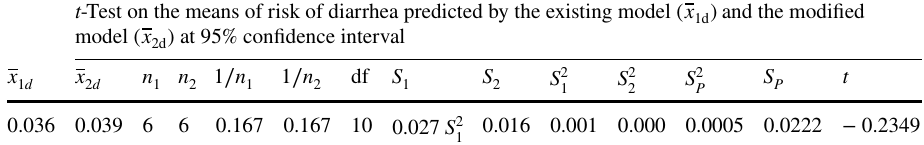
ẍ 1d = mean risk of diarrhea predicted by existing model; model